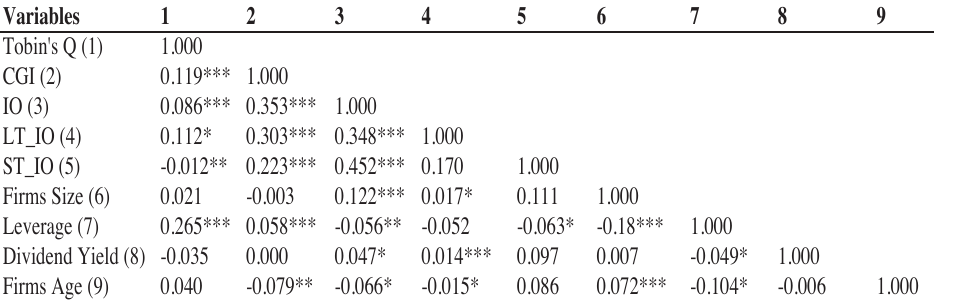
Correlation Matrix